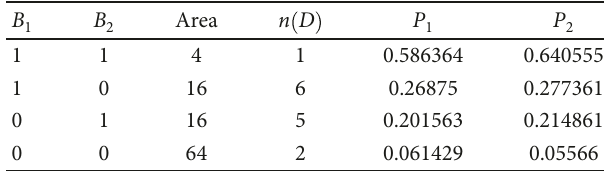
Table 4: Probabilities estimated for unique conditions in the arti fi cial example of Schaeben ([42], Figure 1) with two binary predictors. Area is the number of unit cells; n D represents number of events per unique condition. P 1 is predicted WofE probability and P 2 is predicted modi fi ed WofE probability.